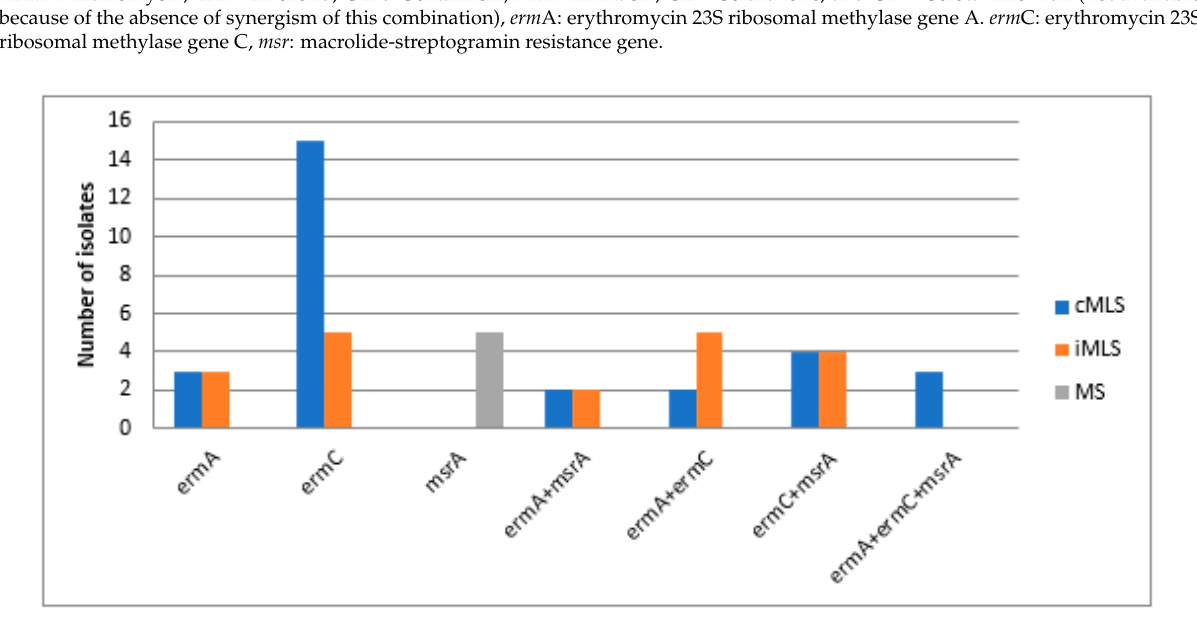
Figure 3. Distribution of MAC-resistance genotypes among the resistant S. aureus isolates. erm A: erythromycin 23S ribosomal methylase gene A. erm C: erythromycin 23S ribosomal methylase gene C, msr : macrolide-streptogramin resistance gene.